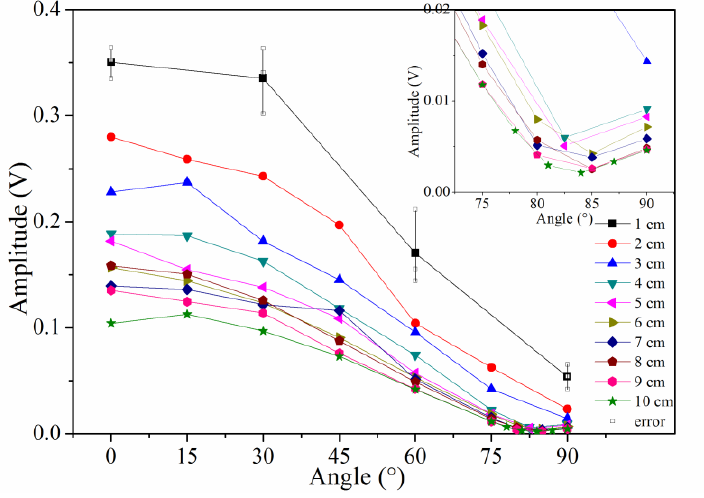
Figure 5. Amplitudes of detected waveforms to the angle change for different distances.